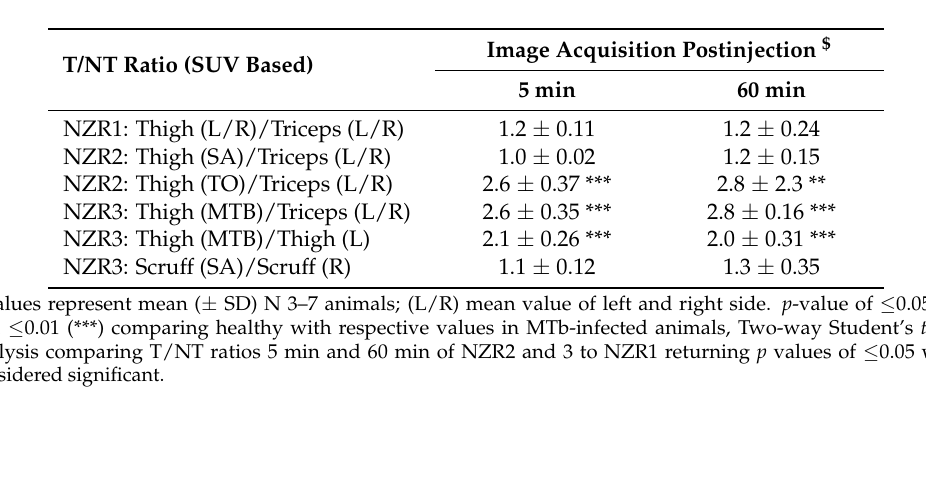
Table 2. Summary of the quantitative analysis of 68 Ga-DOTA-TBIA101 uptake in muscle tissue (group NZR1-3).